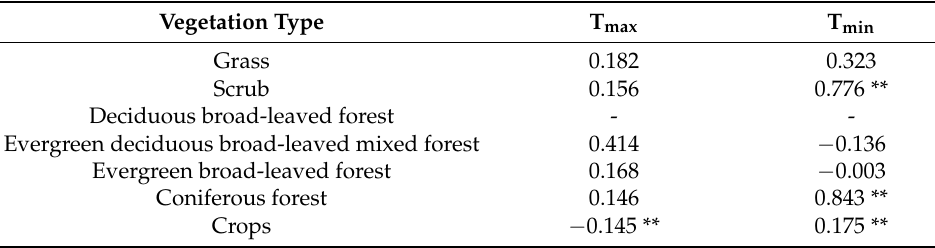
Table 1. Partial correlation analysis of different vegetation types with T max , T min in the Qinba Moun- tains.